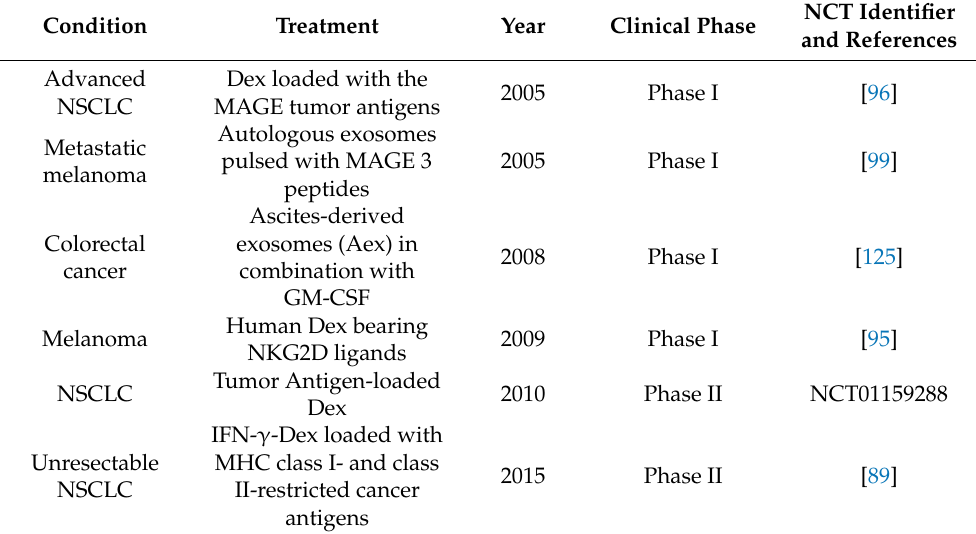
Table 4. Collected currently active or completed clinical trials investigating the use of EVs-based